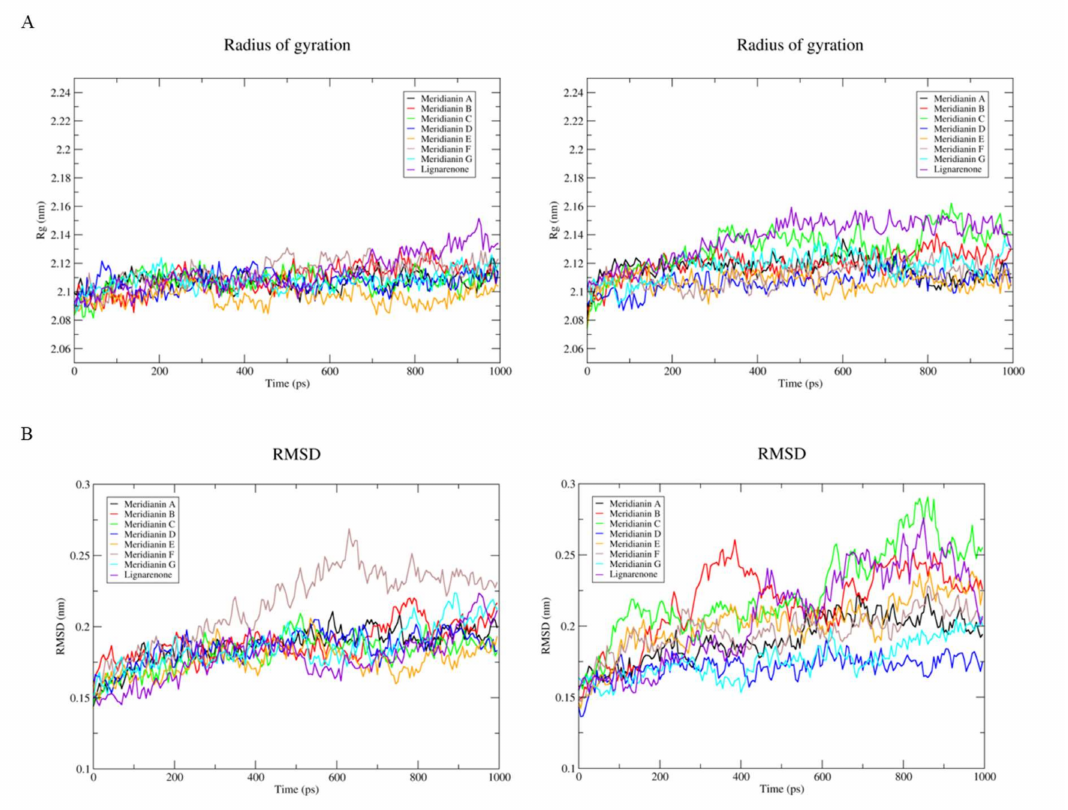
Figure A1. ( A ) Radius of gyration (Rg) and ( B ) Root-mean-square deviation (RMSD)values of each complex, GSK3 β + marine molecules separated per pocket, along the molecular dynamic (MD) simulation. The colour code for each system can be seen in the legend